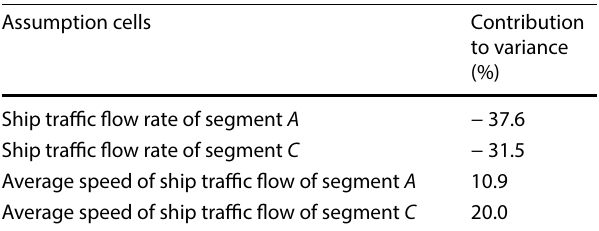
Table 7 Sensitivity analysis of dissipation time Assumption cells Contribution